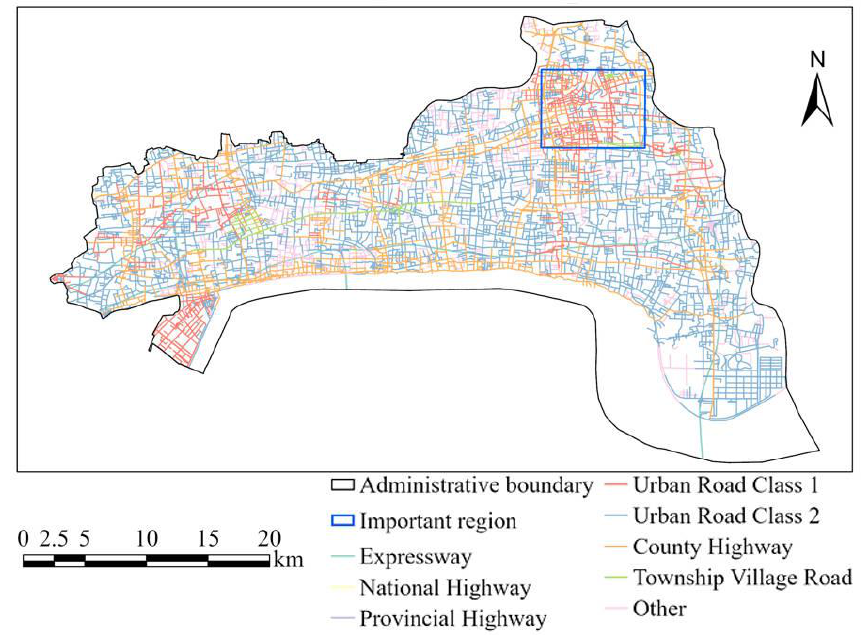
Figure 2. City H road map including expressway, national highway, provincial highway, urban road class 1, urban road class 2, county highway, township village road and others.